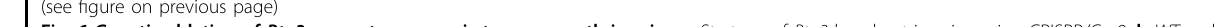
Fig. 6 Genetic ablation of Btg3 promotes syngenic tumor growth in mice. a Strategy of Btg3 knockout in mice using CRISPR/Cas9. b WT and Btg3 − / − littermates produced by crosses between Btg3 + / − heterozygotes. c Genotyping by PCR of isolated tail DNA using either F1/R1 or F1/R2 primers. d , e Validation of Btg3 expression with qPCR ( d ) or western blot ( e ) using RNA or protein prepared from mouse liver. f Scheme for generation of syngenic tumor from LLC1-Luc cells. g LLC1-Luc tumors isolated from WT or Btg3 − / − mice at the experimental endpoint. h Growth curve of the LLC1-Luc tumors in WT and Btg3 − / − mice. Tumor size increased signi fi cantly faster in Btg3 − / − than in WT mice ( n = 7). i Tumors harvested from Btg3 − / − mice weighed more than those from WT mice. j , k Increased staining of the endothelial marker vWF in tumors from Btg3 KO. IHC was performed with paraf fi n-embedded tumor sections using anti-vWF antibody ( j ). Areas stained positive were quanti fi ed and percent positive region representative of each tumor is plotted in ( k ). Scale bar, 200 μ m. l , m Increased lung metastasis in Btg3 − / − mice, as evidenced by IHC staining for luciferase (L) and its quanti fi cation (M). Scale bar, 200 μ m. n Serum LDH levels in tumor-bearing WT and Btg3 − / − mice. o Expression of selected genes in LLC tumors as assessed by qPCR.